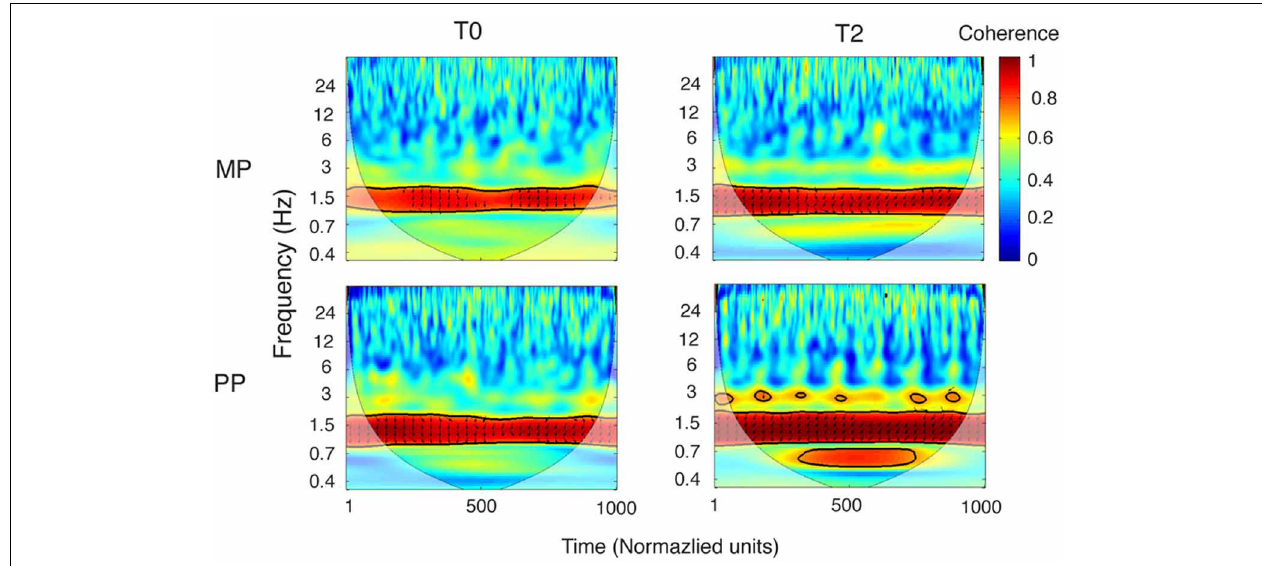
FIGURE 5 | Coherence between the wrist and finger velocity profiles. Grand-averages of the coherence between the wrist and fingers velocity profiles, for the MP and PP group (in each, n = 8). Coherence is represented in the time-frequency space, with time normalized to 1000 units (the corresponding duration of performance was ∼ 7.5s). The cone of influence, where edge effects might distort the picture, is shown as a lighter shade. A high level of coherence indicates a systematically phase-locked behavior. The areas of statistically significant coherence (5% significance level against red noise) are shown surrounded by a thick black contour. It can be noticed that the wrist and the finger